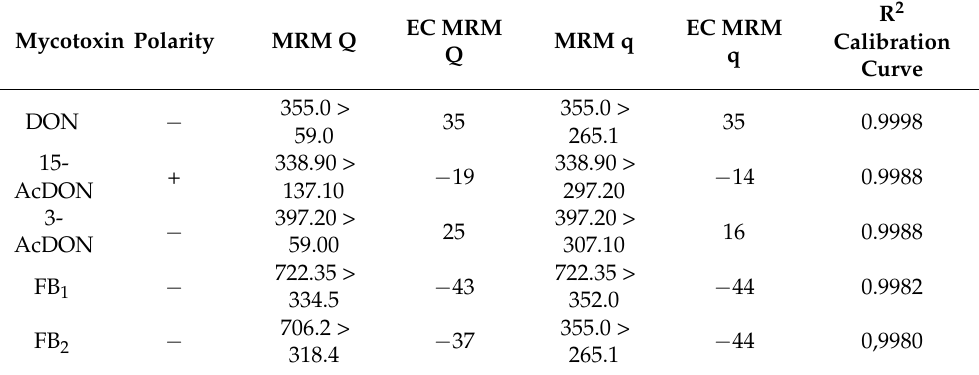
Table 2. MS/MS parameters for mycotoxins. (Q) Quantification; (q)